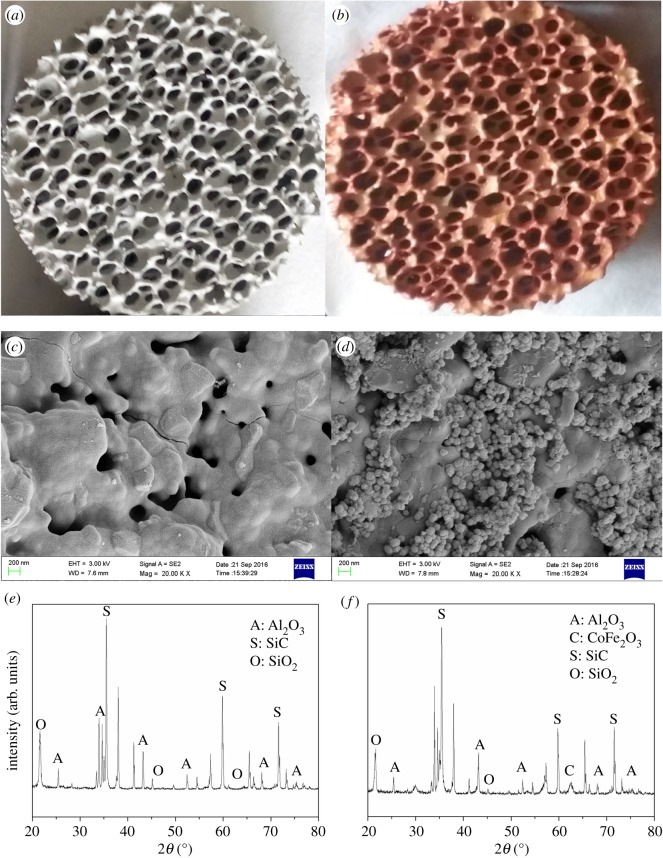
Photographs of (a) SiC and (b) CoFe2O4–SiC foams. SEM images of (c) SiC and (d) CoFe2O4–SiC foams. XRD patterns of (e) SiC and (f) CoFe2O4–SiC foam.